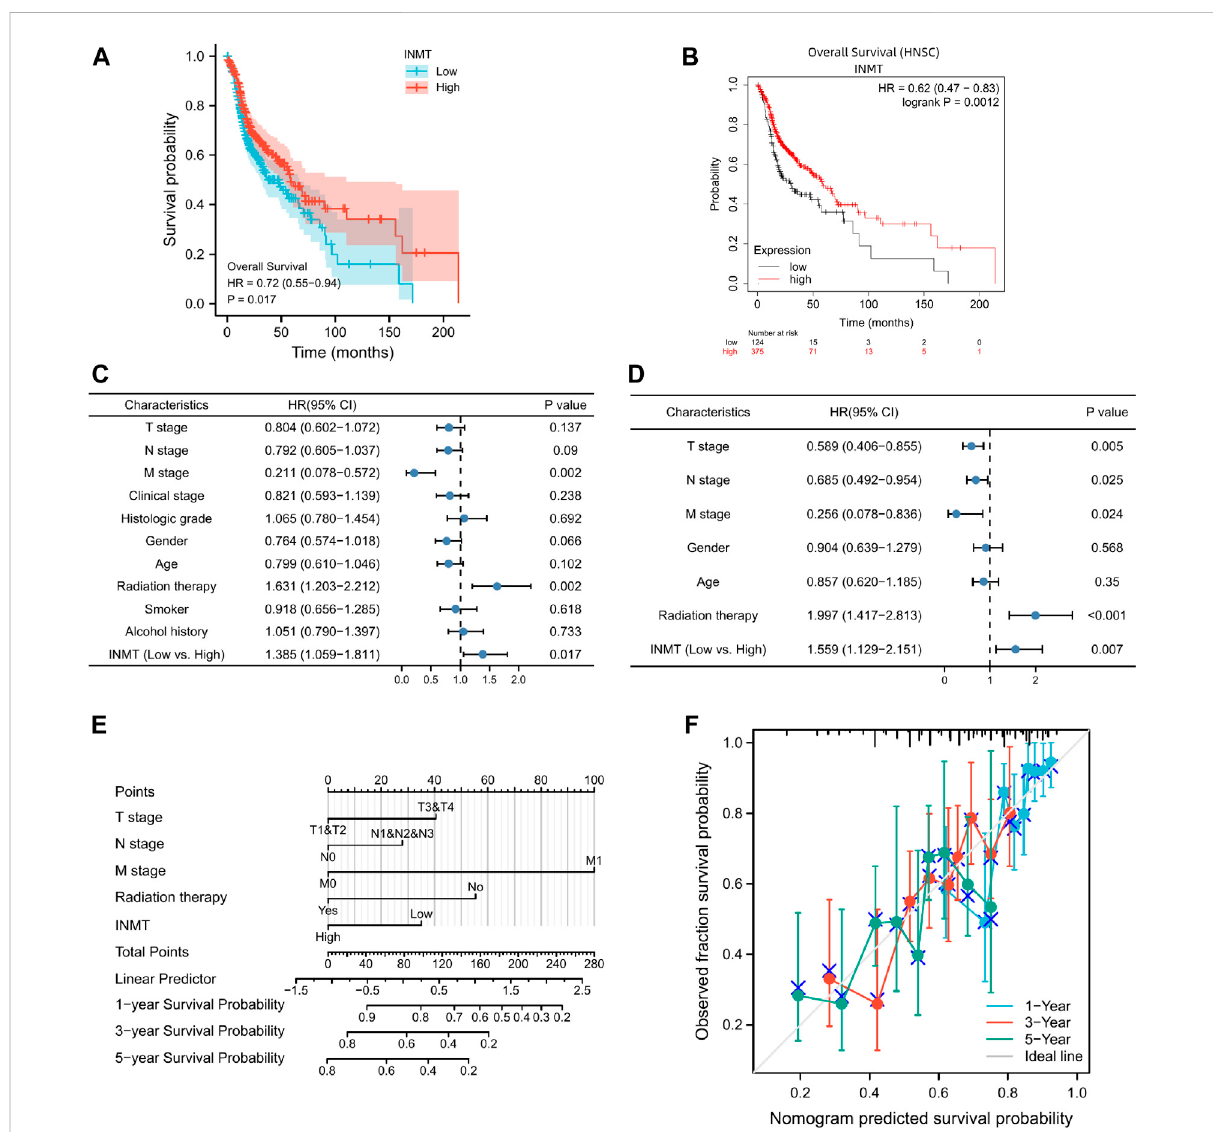
FIGURE 3 The prognostic signi fi cance of INMT expression in HNSC. (A) A survival curve for OS based on TCGA data; (B) A survival curve for OS based on Kaplan-Meier Plotter; (C,D) Univariate and multivariate Cox analyses of INMT and pathological characteristics; (E) A nomogram incorporating INMT and other prognostic factors for HNSC utilizing TCGA data; (F) The calibration curve of the